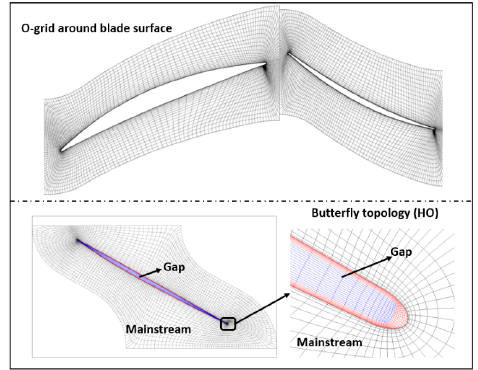
Figure 2. Typical mesh topology.